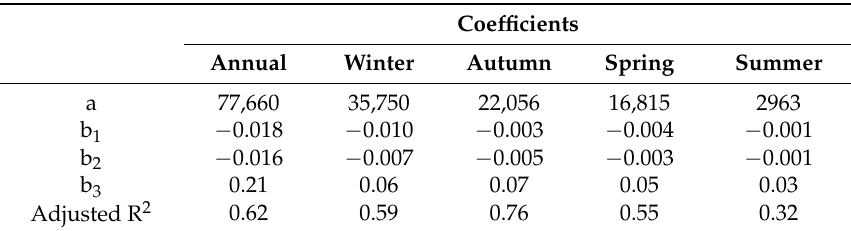
Table 6. Coefficients of multiple regression models and statistics.